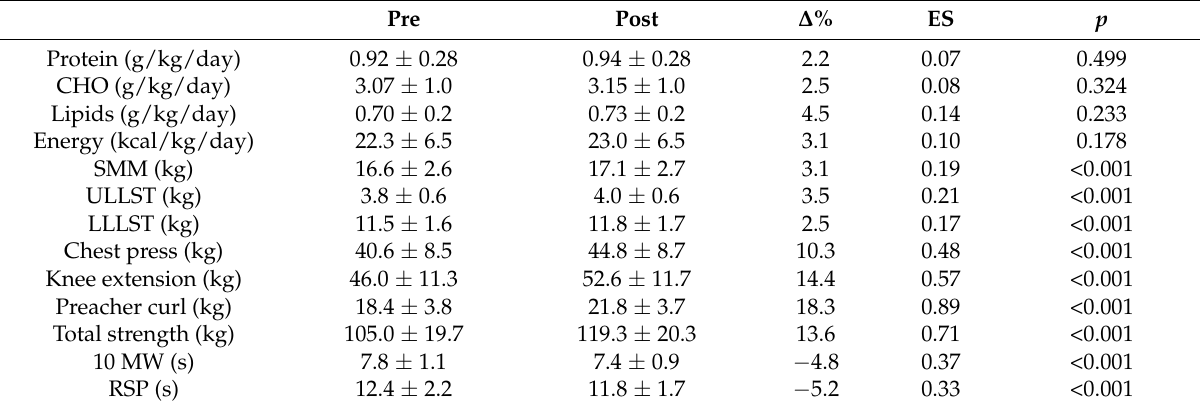
Table 1. Participant scores at baseline (pre) and after (post) the eight-week period ( n = 70).